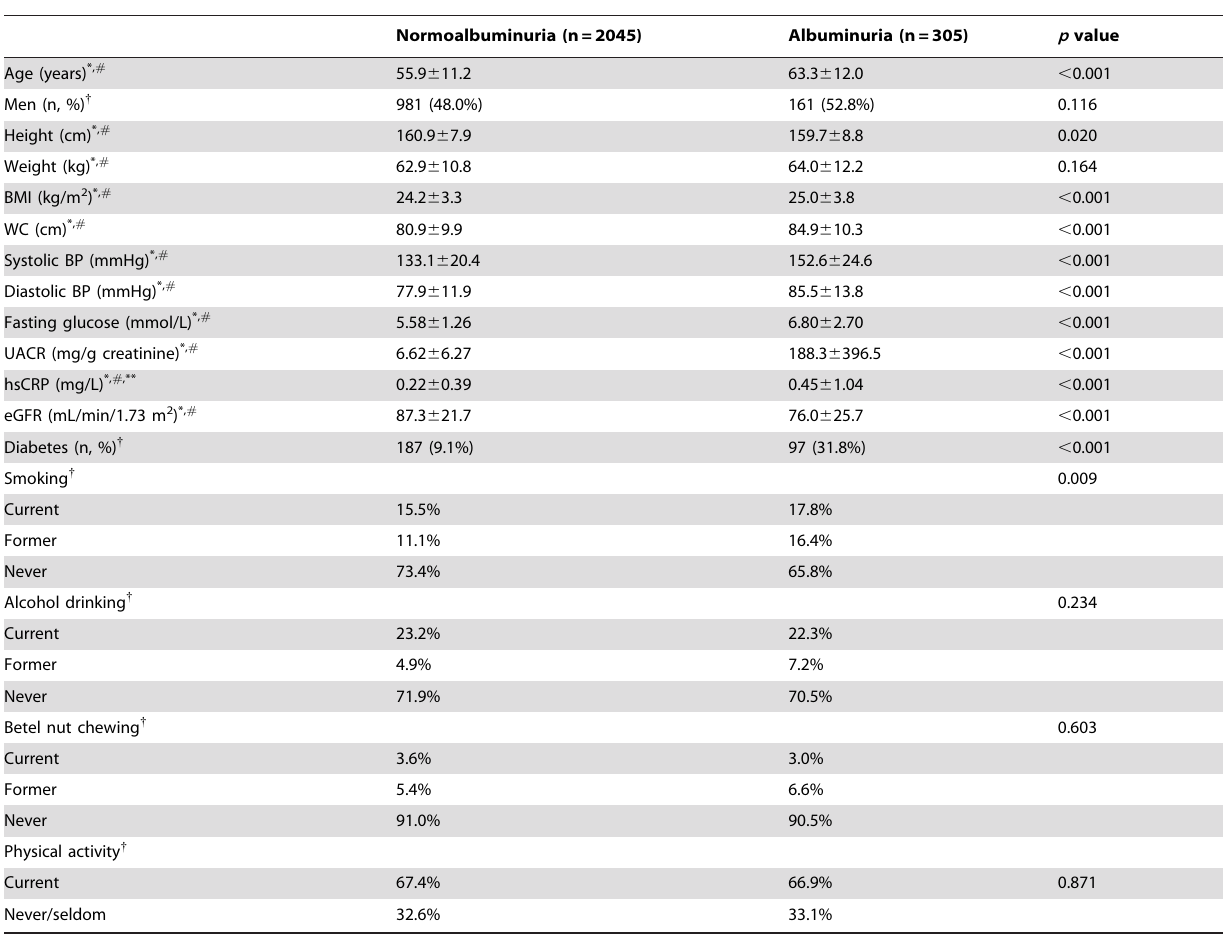
Table 2. Baseline characteristics according to albuminuria level (n =2350) {